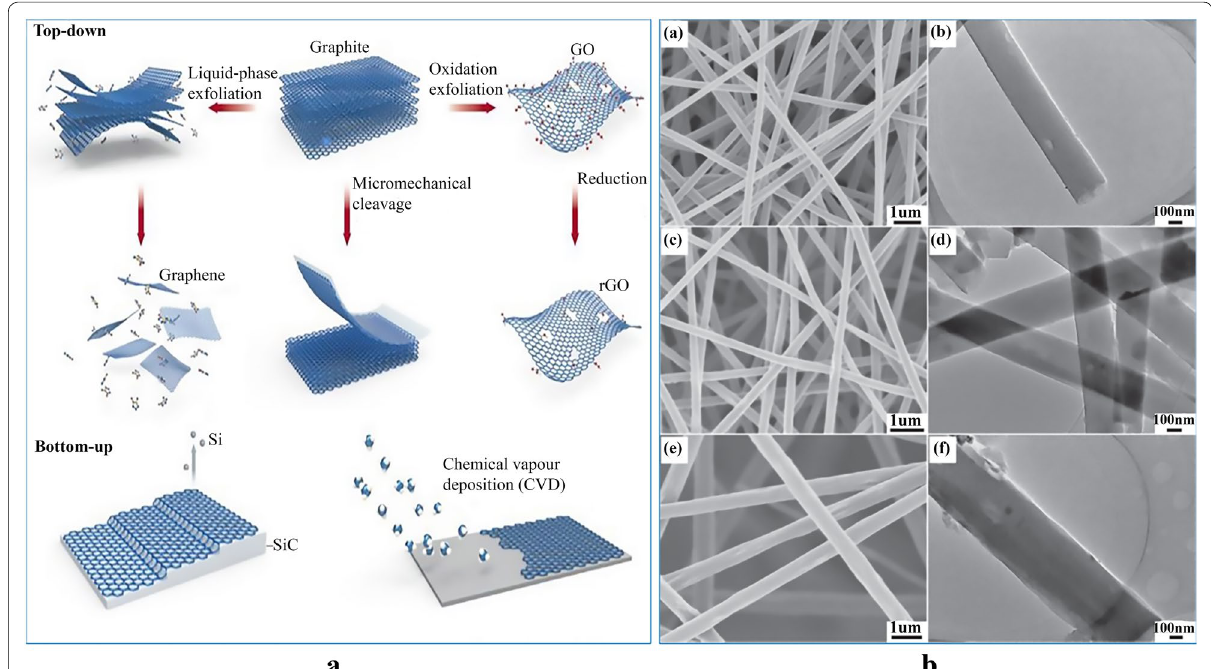
Fig. 1 a Major fabrication methods of graphene: Top‑down and bottom‑up fabrication methods. Principal top‑down methods include liquid‑phase exfoliation and micromechanical cleavage of graphite. An additional method involves the exfoliation of initially oxidized graphite, leading to GO, which is chemically and/or thermally reduced to graphene. The bottom‑up fabrication of graphene is usually performed by epitaxial growth on SiC or chemical vapour deposition, typically on Cu using small molecules, such as methane, as precursors. Reproduced with permission from [174] Copyright 2017 Nature Publishing Group. b SEM (a, c, e) images and TEM images (b, d, f) of nanofibers (a, b), nanofibers‑rGO‑5 (c, d), and nanofibers‑rGO‑10 (e, f) with different magnifications Reproduced with permission from [173] Copyright 2019